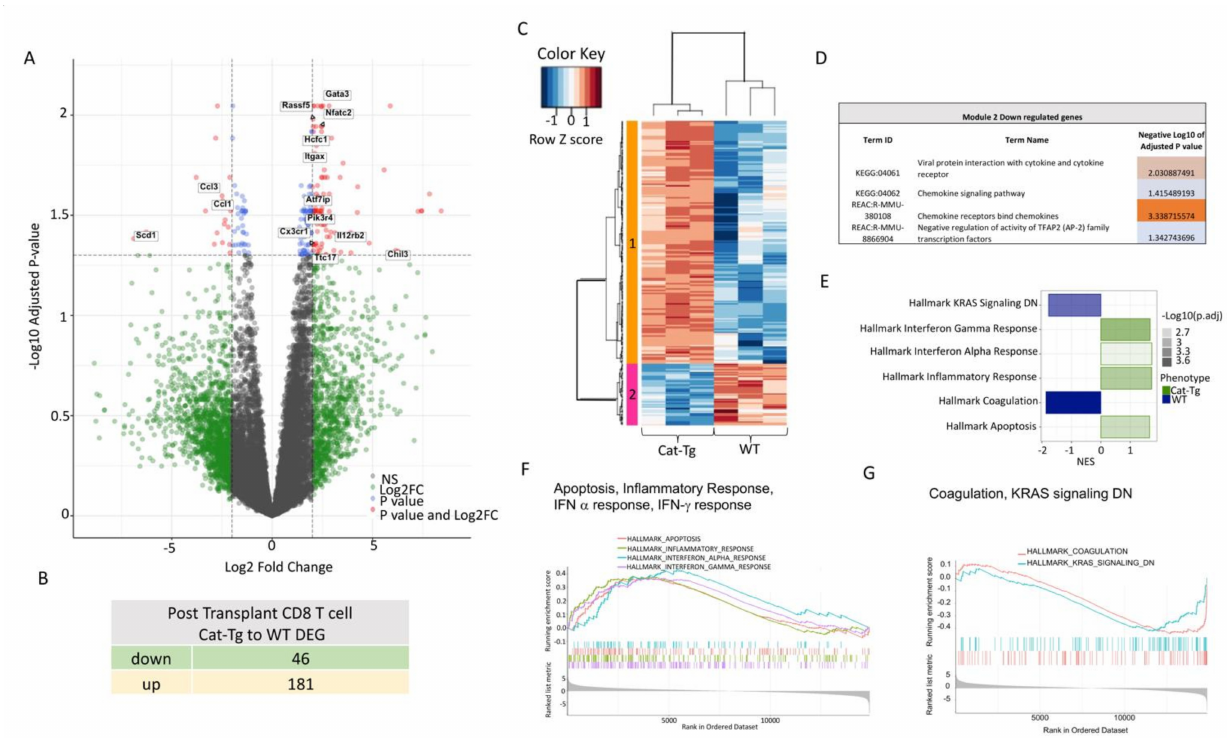
Figure 5. β -catenin overexpression differentially regulates gene expression in post-transplanted donor CD8 + T cells. ( A ) Volcano plot displaying 227 differentially expressed genes (FDR 0.05, logFC 2) between Cat-Tg and WT post-tx ≤ ≥ CD8 + T cell samples. Positive log fold change corresponds to increased expression in Cat-Tg samples. ( B ) Table showing the number of up- or downregulated DEGs between groups. ( C ) Hierarchical clustering and heat map illustrating expression of genes compared between different groups selected by strain and timepoint. All replicates are shown ( n = 3) for each group. ( D ) Table showing GO enrichment analysis of DEGs of post-tx CD8 + T cells. Using the online tool gProfiler and the ordered g:GOSt query, we assessed which biological processes (BP) were linked to the genes in the different modules from post-tx CD8 + T cells. On the table, adjusted p -values were color-coded as light blue for insignificant findings to orange with highest significance. ( n = 3 mice per group). ( E ) A bar plot showing up- or downregulated pathways based on enrichment scores in GSEA in post-tx WT or Cat-Tg CD8 + T cell samples. Negative Normalized Enrichment Score (NES) is indicator of downregulation and positive NES is indicator of upregulation of the genes in the corresponding pathway. Color specifies the group ( WT or Cat-Tg) in which expression is altered (phenotype), color transparency indicates the negative Log10 of adjusted p -value. ( F , G ) GSEA enrichment plots of gene clusters that are enriched in Cat-Tg , including Hallmark of Apoptosis, Hallmark of Inflammatory Response, Hallmark of Interferon-alpha response, and Hallmark of Interferon gamma response. ( G ) GSEA enrichment plots gene clusters that are enriched in WT, including Hallmark of Coagulation and Hallmark of KRAS signaling